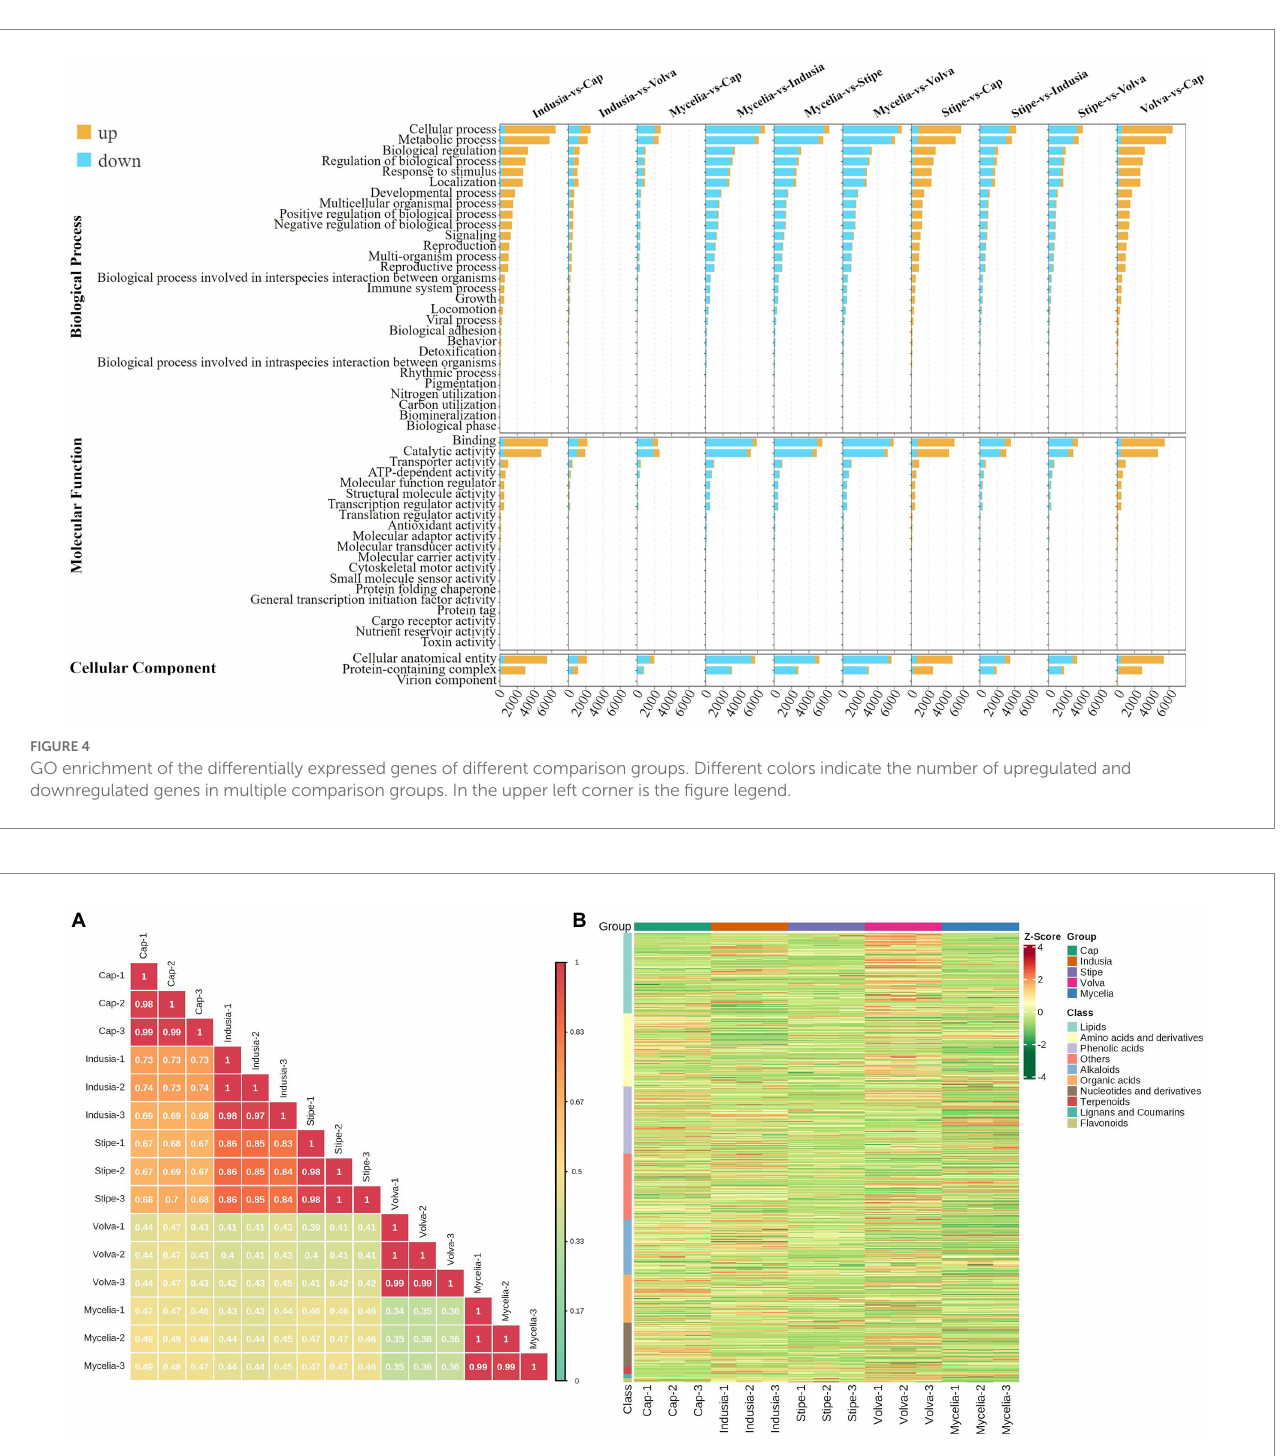
FIGURE 5 Metabolite composition of five DI tissues. (A) Pearson’s correlation heat map. The longitudinal and diagonal lines show the sample names, and different colors represent the different Pearson correlation coefficients; the key is shown on the right side. (B) Clustering heat map of all metabolites. Each column represents a sample, and each row represents a metabolite class. A color bar represents the metabolite abundance. Different shades of red and green represent the upregulated and downregulated metabolites,